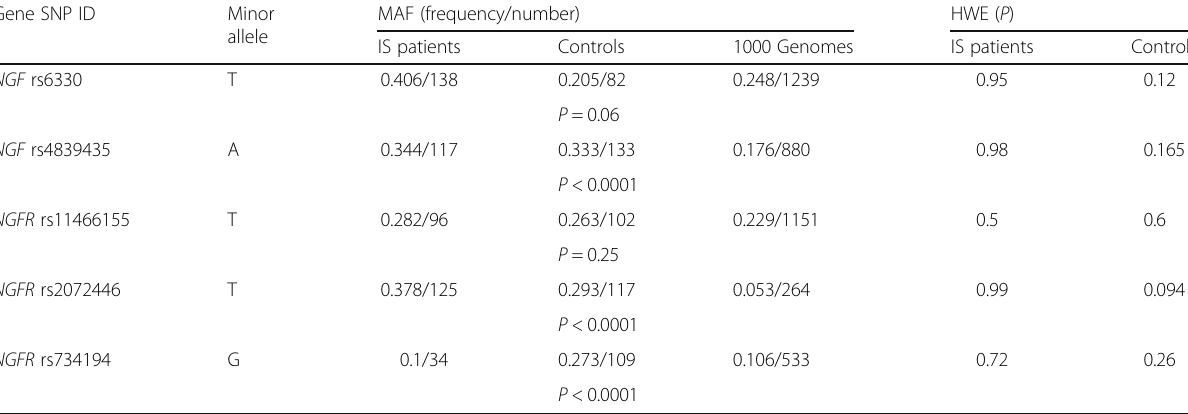
Table 2 HWE and MAFs of the selected SNPs in the studied groups and in major